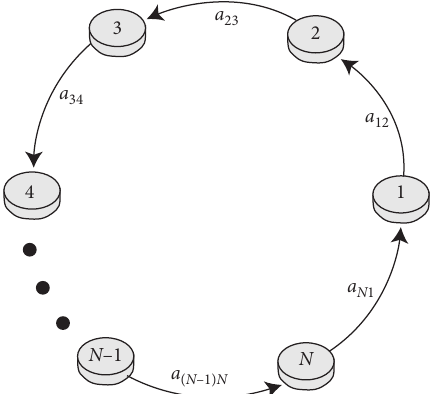
Figure 2: A weight-unbalanced digraph G with N